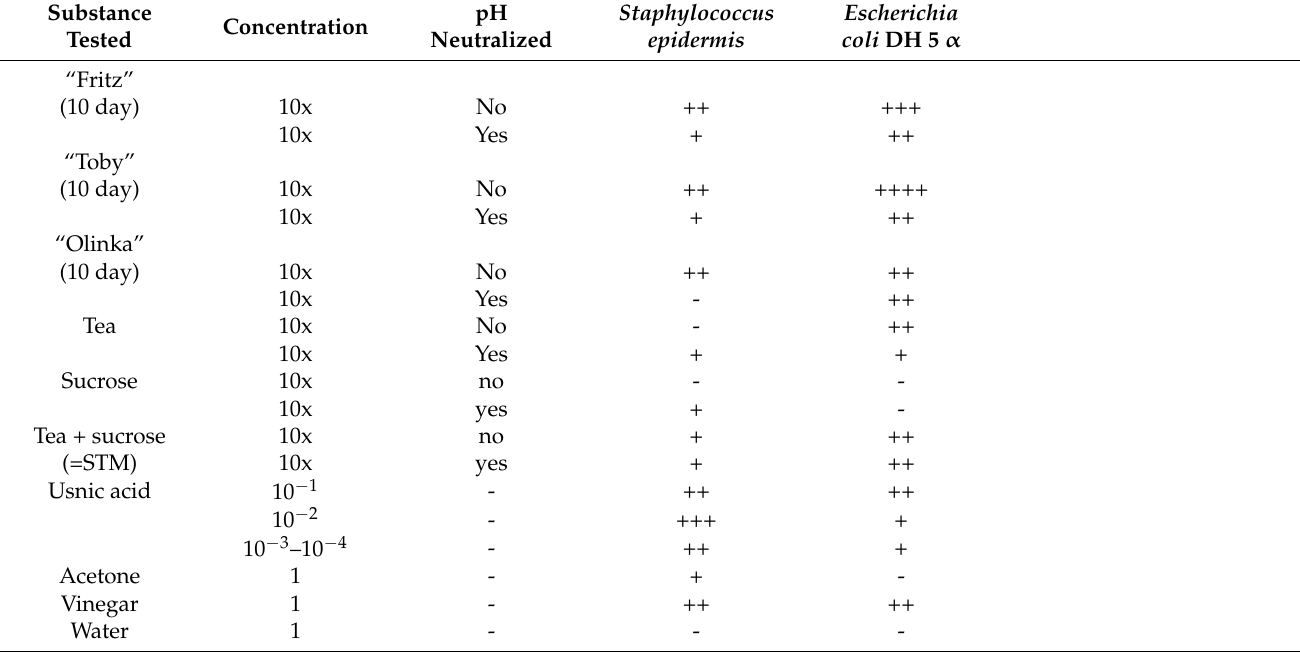
Table 3. Inhibition of Staphylococcus epidermis and Escherichia coli DH 5 α by concentrated kombucha tea ferments and